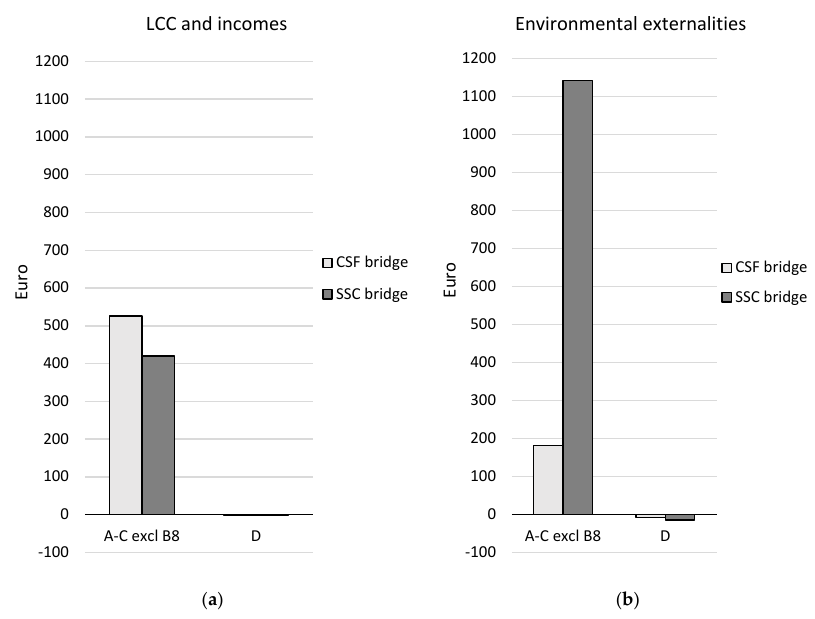
Figure 9. Comparison of the design concepts per life cycle stage for ( a ) the LCC and incomes and ( b ) the environmental externalities; presented in Euros for the functional unit. Module B8 is not included in the comparison. Int. J. Environ. Res. Public Health 2020 , 17 , x